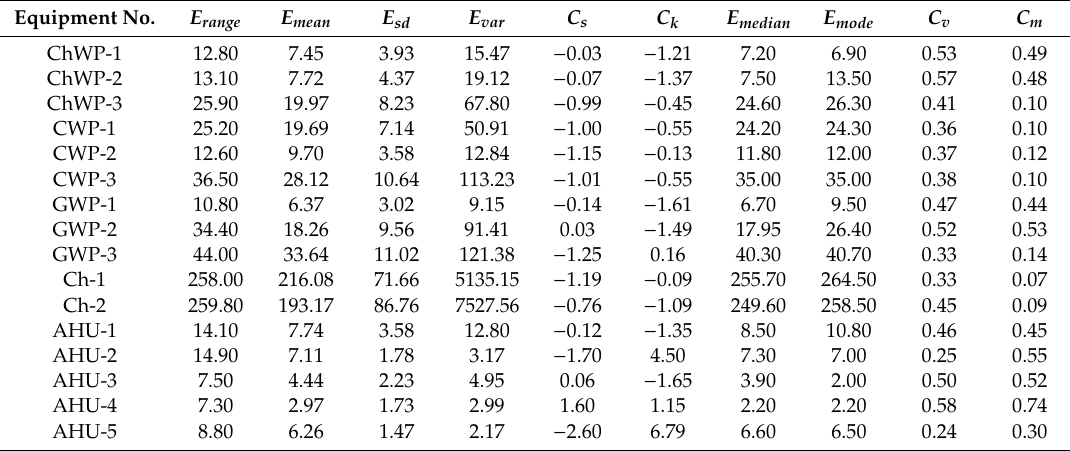
Table 1. Numerical characteristics of energy consumption distribution of 16 ME items in the case study. ChWP, chilled-water pump; CWP, condensing-water pump; GWP, glycol water pump; Ch, chiller; AHU, air-handling